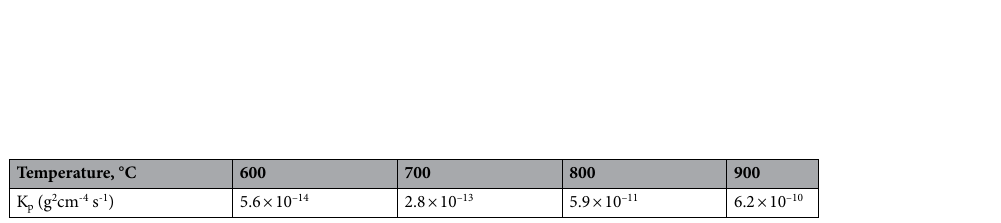
Figure 3. Thermal oxidation kinetics of TC21 Ti-alloy as a function of oxidation time at different temperatures.